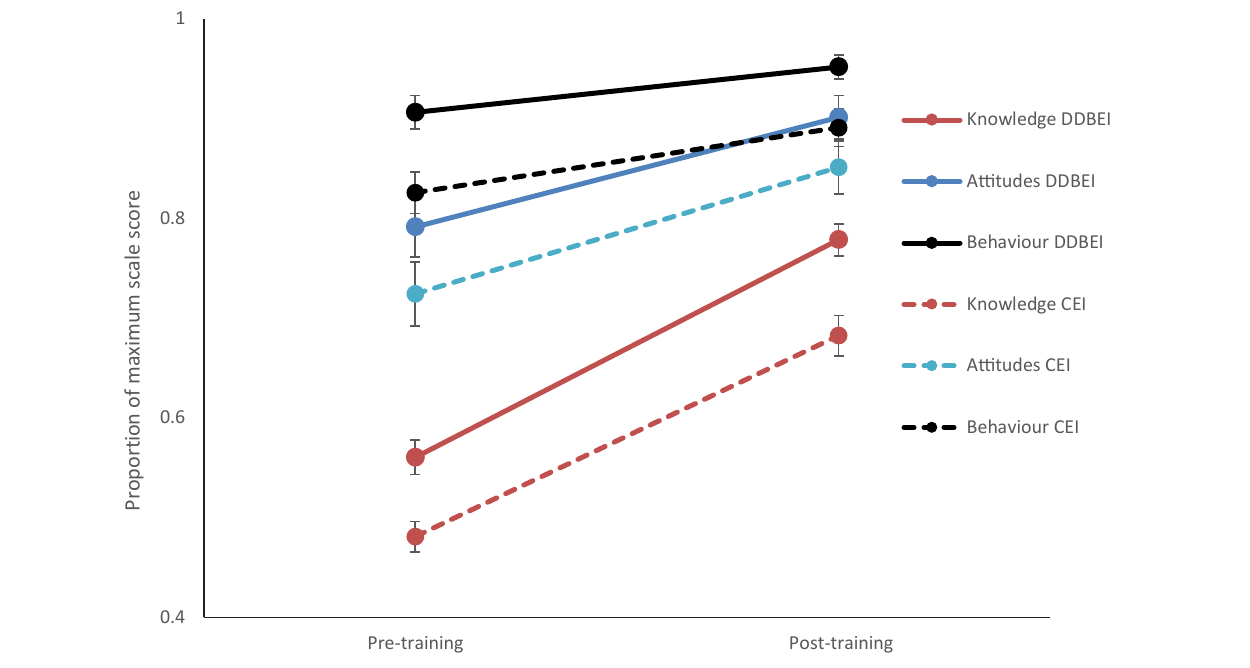
FIGURE 2 | Graph of mean Knowledge, Attitude and Behavior scores as a proportion of the maximum possible on each scale, before and after training with the Dangerous Decibels (DDBEI) and Conventional (CEI) training methods. Error bars represent one standard error of the